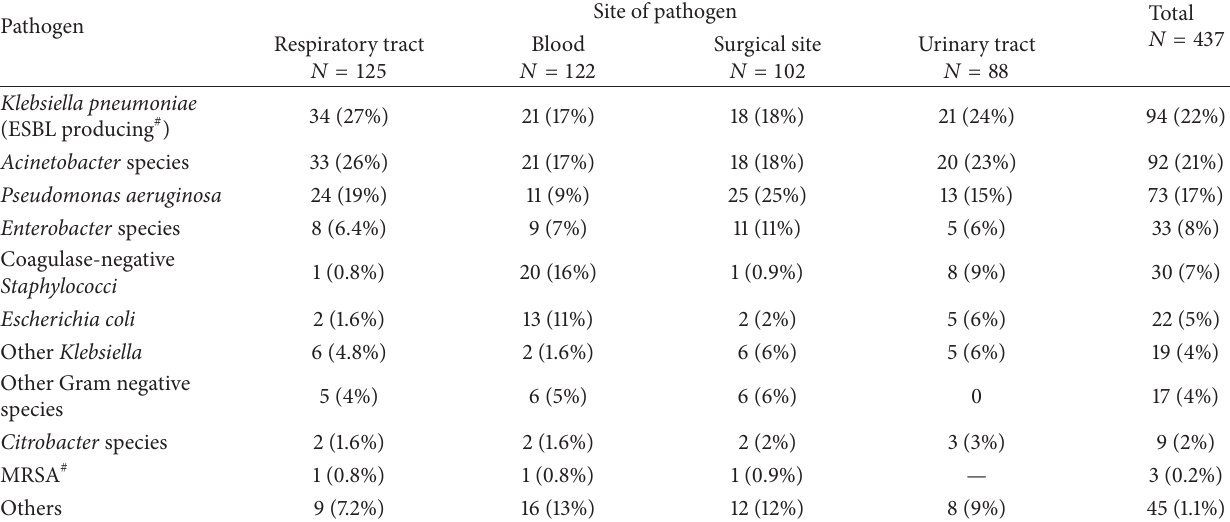
Site of pathogen Total 𝑁 = 437 Blood Surgical site Urinary tract 𝑁 = 122 𝑁 = 102 𝑁 =